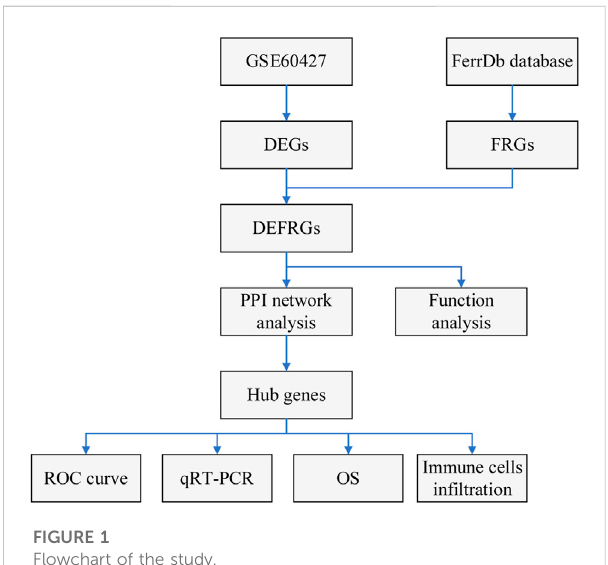
FIGURE 1 Flowchart of the